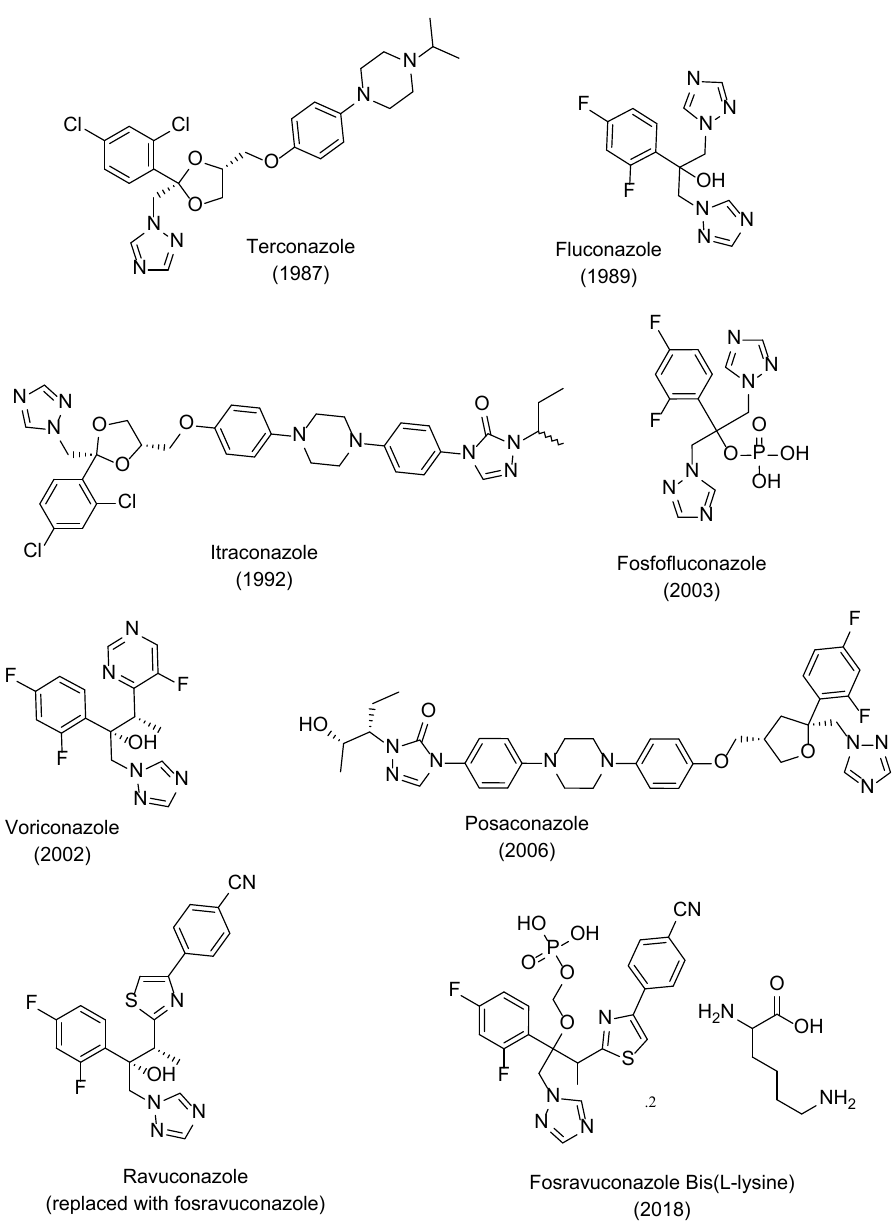
Figure 3. Structures and approval dates of triazole antifungal drugs